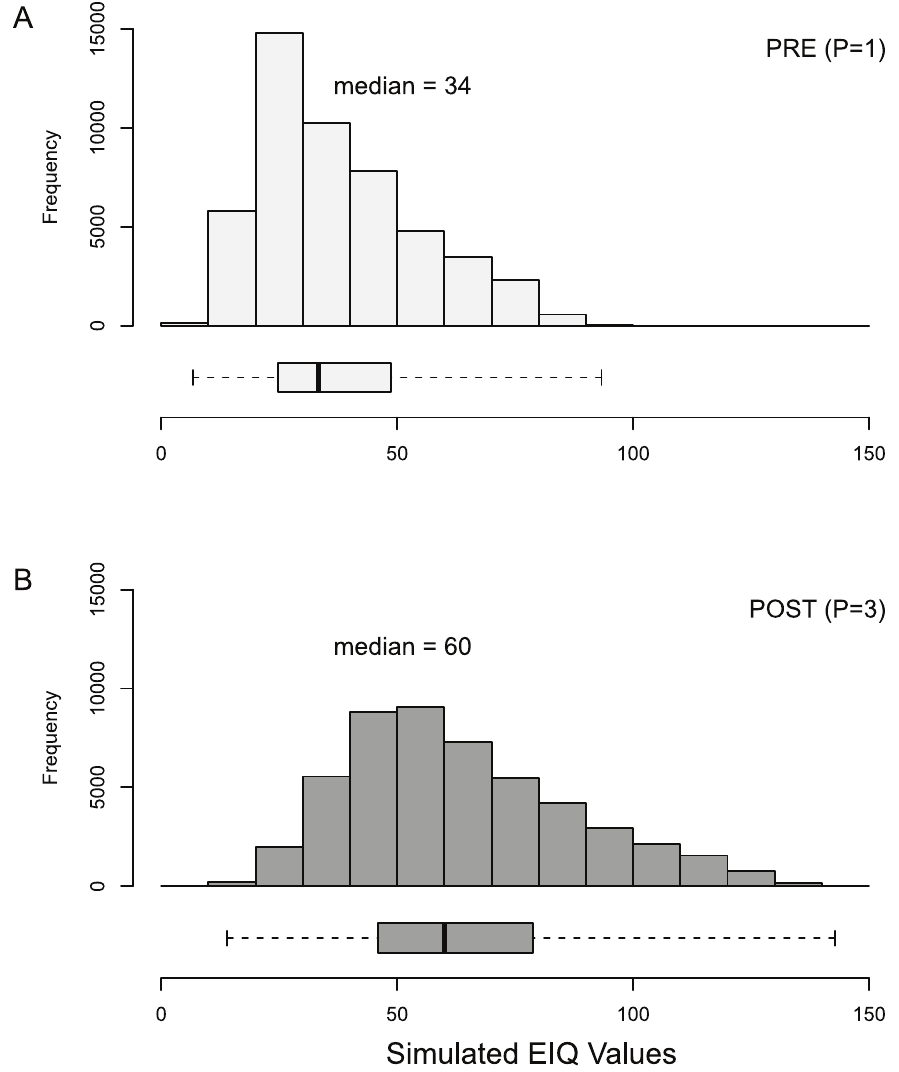
Fig 2. Histogram of Monte Carlo simulation of 100,000 EIQ values calculated by random draws of values for risk factors included in the EIQ formula (Eq 1). For box-plots, dark bars represent median EIQ value, boxes enclose the first and third quartiles, and whiskers extend to minimum and maximum observed EIQ values.